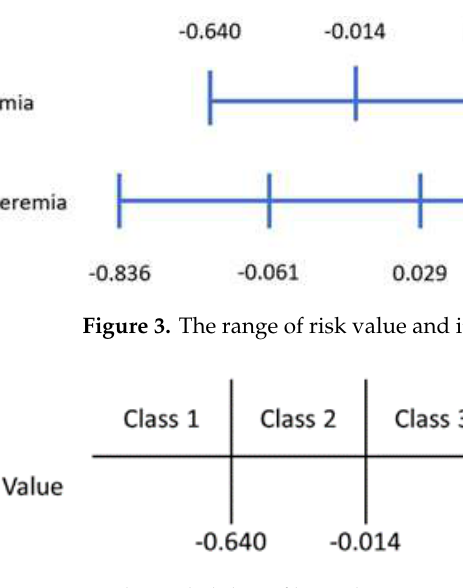
Figure 4. The probability of being bacteremia classified by risk value.